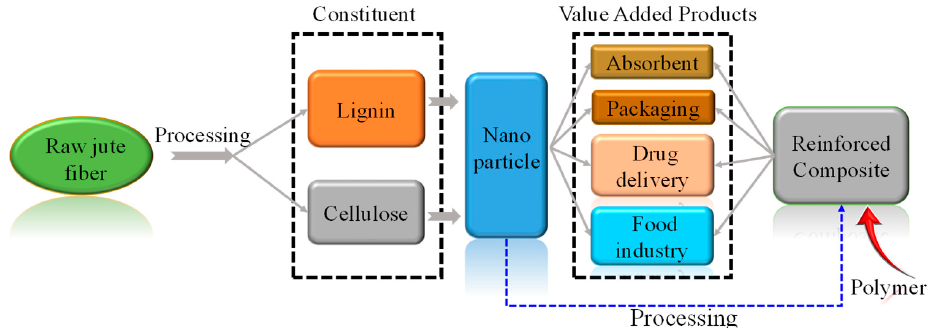
Figure 22. Examples of product development with jute nanoparticles.